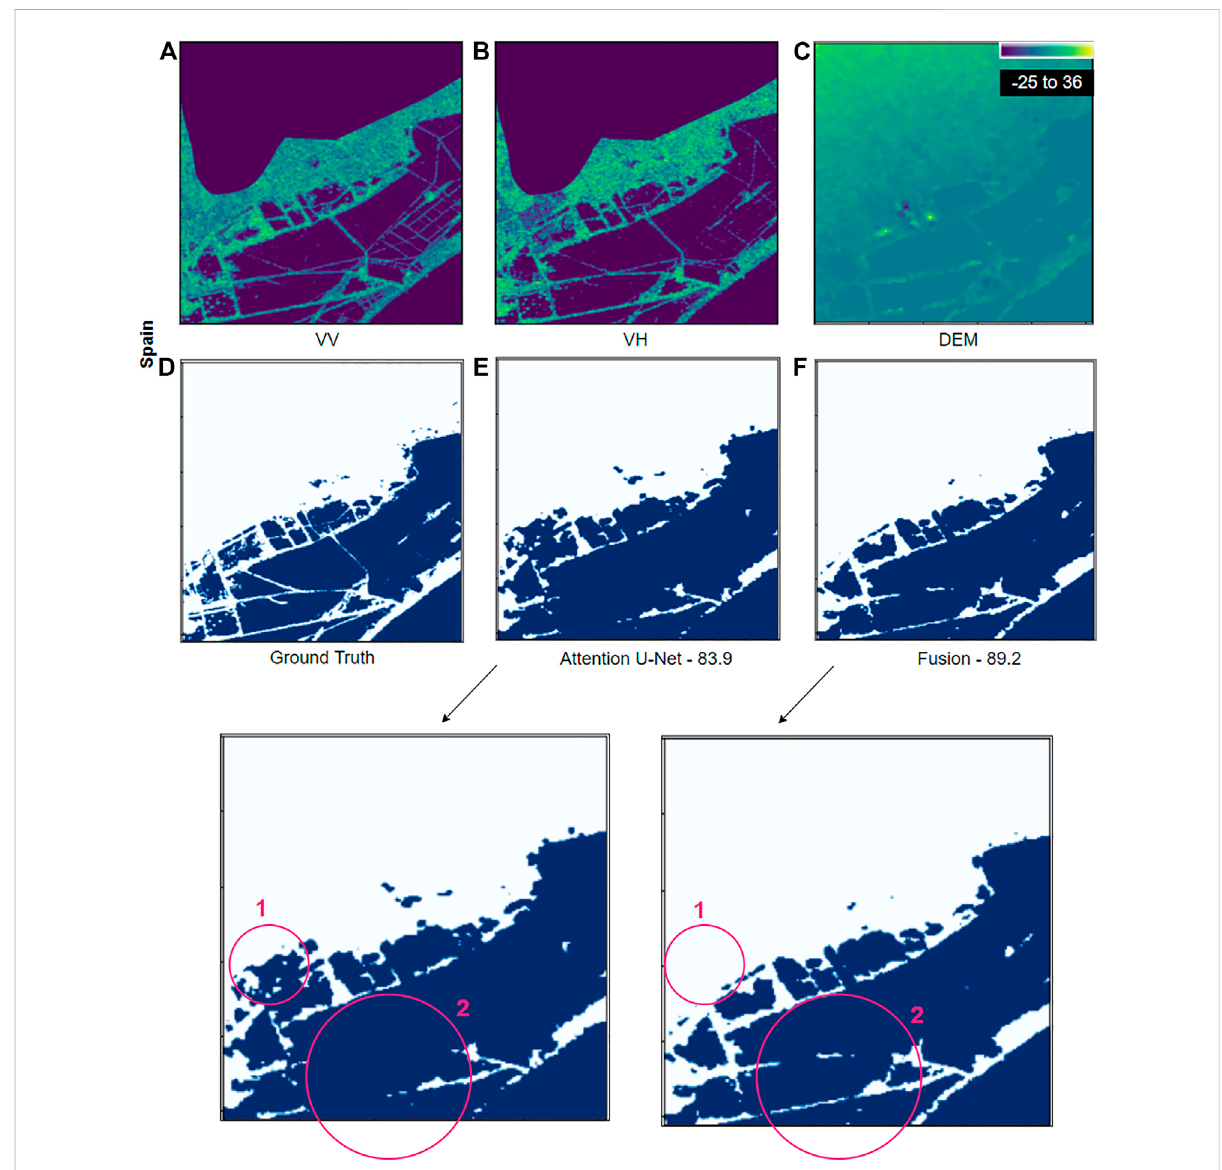
FIGURE 5 Detection result samples from the Spain site. In visualization contains (A) VV, (B) VH, (C) DEM, (D) ground truth, (E) attentive U-Net network prediction, and (F) fusion network prediction. Third row contains zoomed version of (E) and (F) . The red circles highlight the areas described in the text. The numbers speci fi ed under the prediction maps are the corresponding IoU